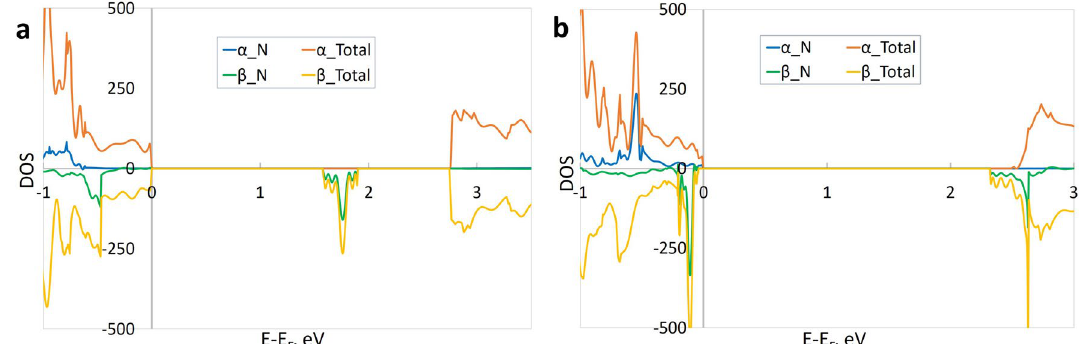
Figure 2. The electronic DOS for slabs with substitutional N atom. ( a ) N in the central layer of the slab (SG 25); ( b ) N on the surface of the slab (SG 6). α_Total, β_Total—total DOS for alpha- and beta-electrons, α_N, β_N— DOS projected onto N atom (alpha- and beta-electrons); the zero value of the energy corresponds to the Fermi